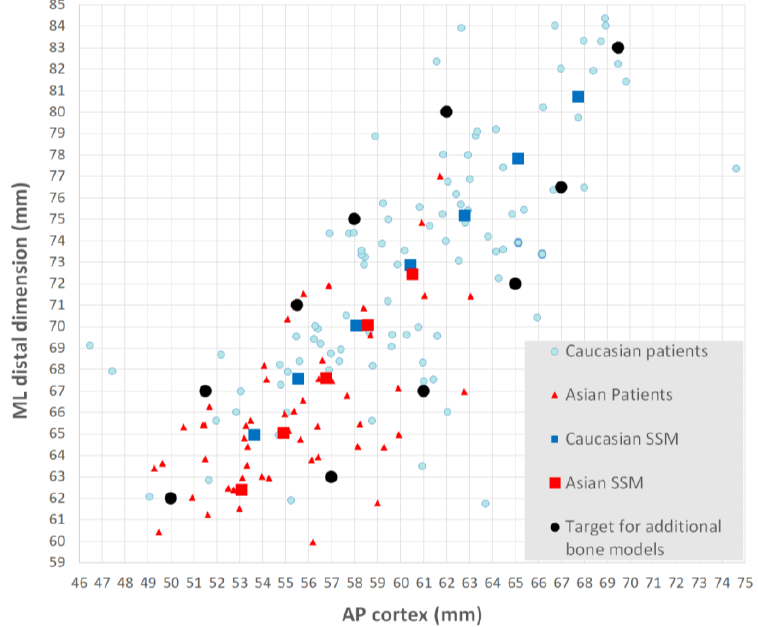
Figure 5. AP/ML dimensions on the Caucasian and Asian population, the SSM and the 10 addition-